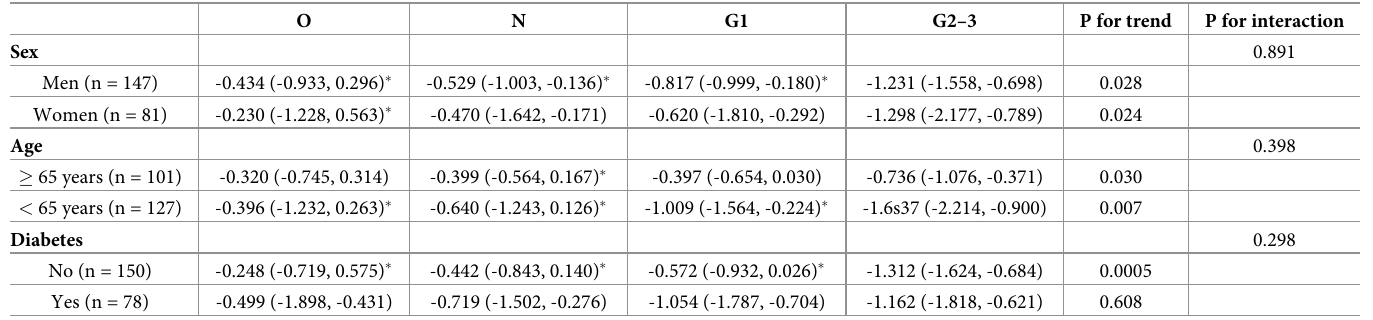
Table 4. Multivariable-adjusted mean decline rate of log RKF with 95%CI in the subgroups of BP 3M